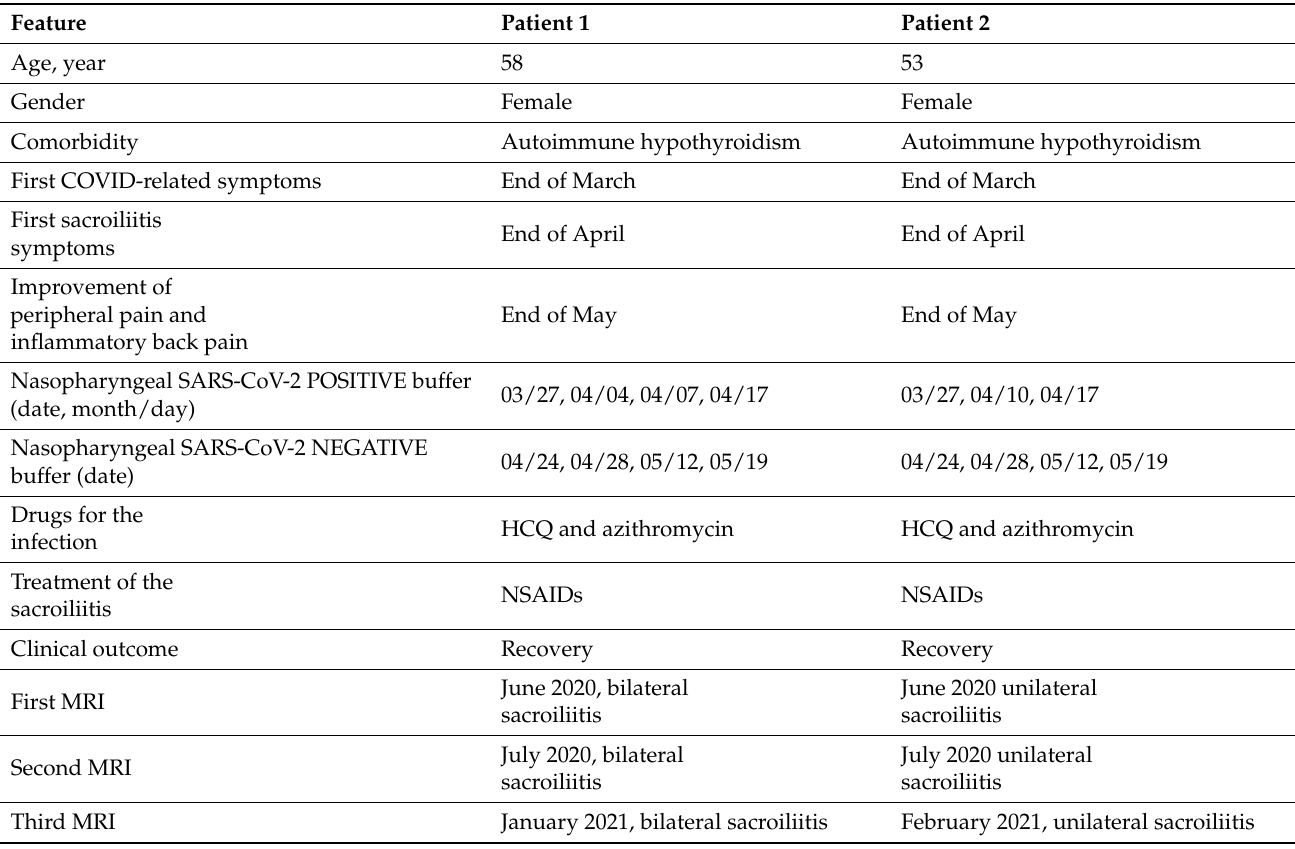
Table 1. Demographic and clinical characteristics of the two patients with reactive sacroiliitis post COVID-19 infection. Feature Patient